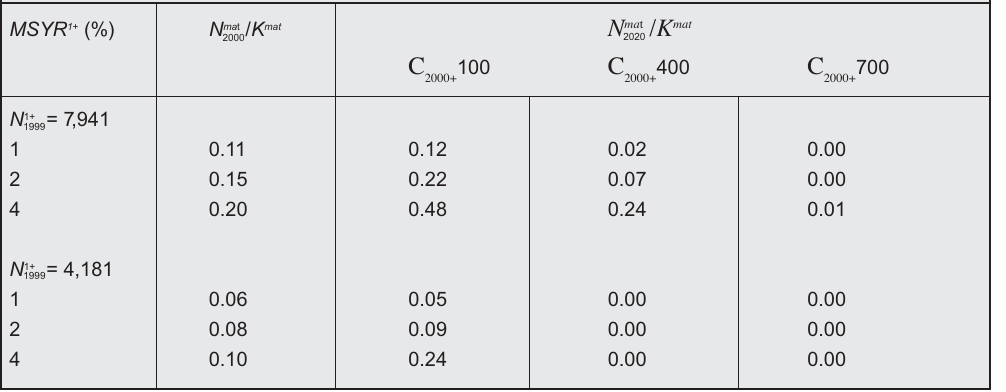
Table 2 : Depletion statistics ( N ma t / K mat ) for the mature female component of the population when hitting the best estimate (7,941) and corresponding lower 5%-ile (4,181) total (1+) population si- zes in 1999 for various values of MSYR 1+ for the single stock scenario (“Total” catches) and pro- jecting forward to 2020, assuming constant future catches (C per